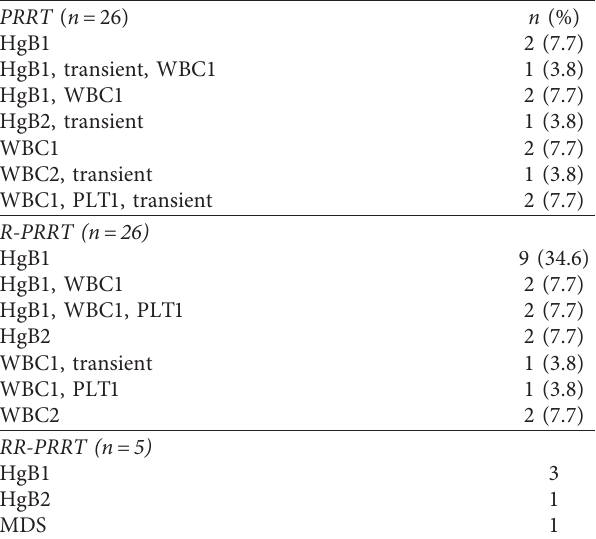
Table 2: Bone marrow toxicity of [ 90 Y]Y/[ 177 Lu]Lu-DOTATATE.